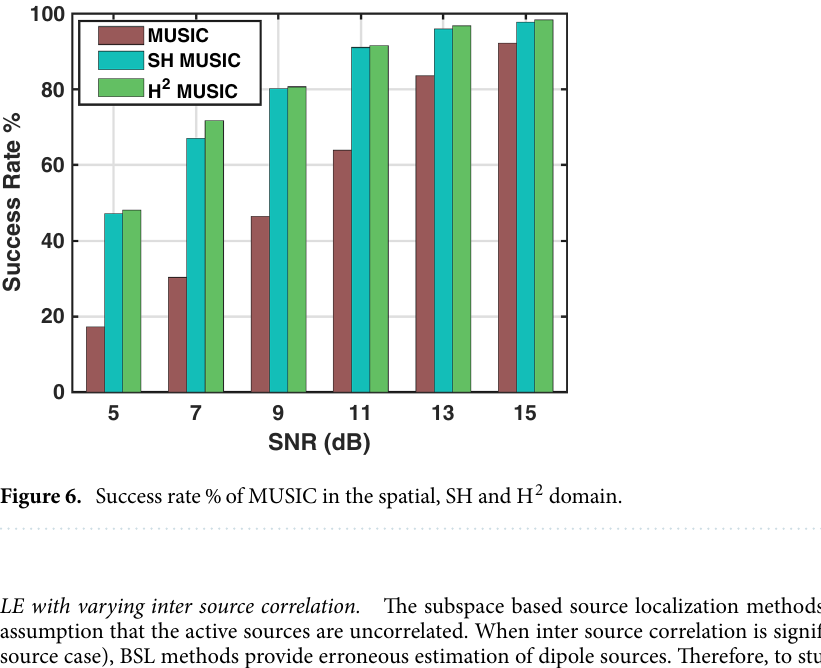
Figure 6. Success rate % of MUSIC in the spatial, SH and H